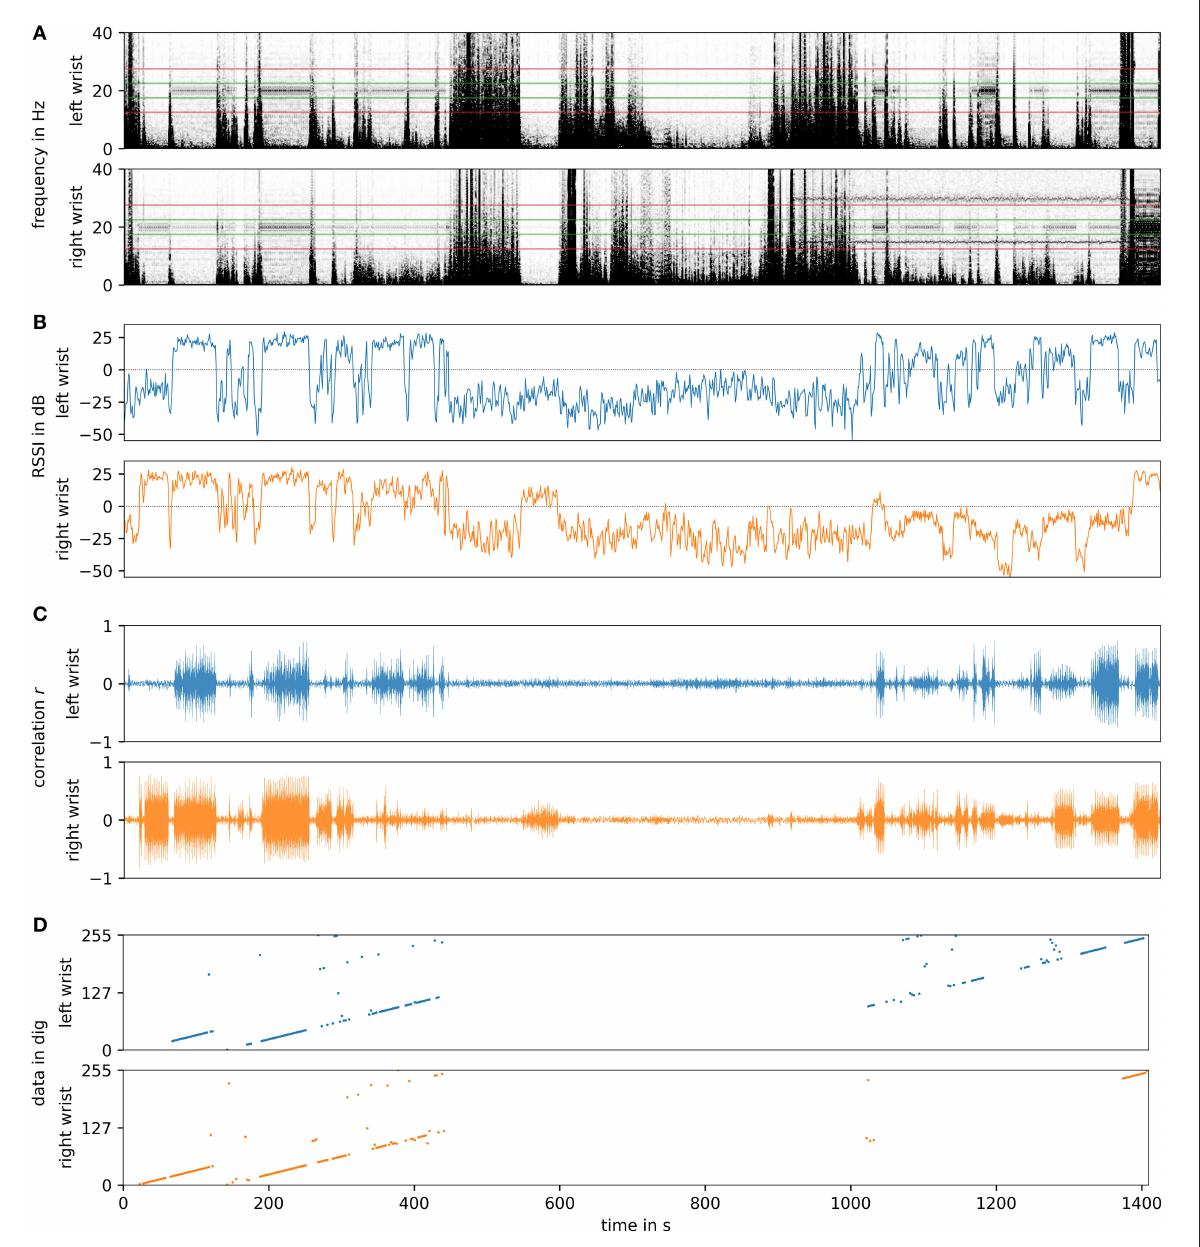
FIGURE12 Output of the processing pipeline for the in-the-wild experiment: (A) short-time Fourier transform (STFT) with a window length of 4s (512samples) and 75% overlap, presence of the signal core in 17 . 5–22 . 5Hz (green lines) and in-band noise in 12 . 5–17 . 5Hz and 22 . 5–27 . 5Hz (red lines); (B) received signal strength indicator (RSSI) derived from the signal core and the adjacent in-band noise; (C) Pearson’s r , normalized cross-correlation, maxima of the detected landmarks; (D) decoded data d , partly damaged information, erroneously detected pulses within the data segment, considerable disruption through motion. Correlation excecuted if RSSI > 0dB, data decoded if r ≥ 0 . 65 and preamble amplitude ≥